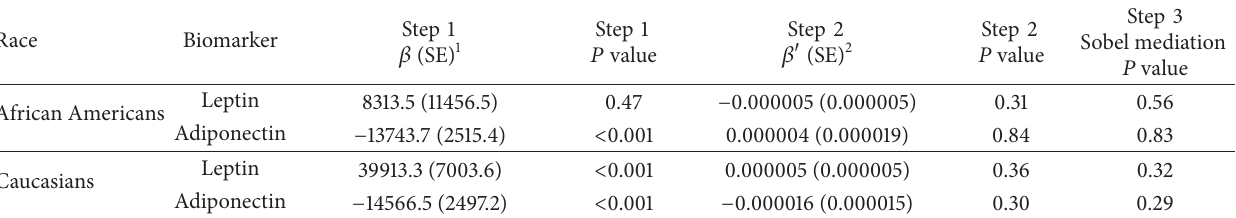
Table 2: Race-stratified mediation analysis [17].